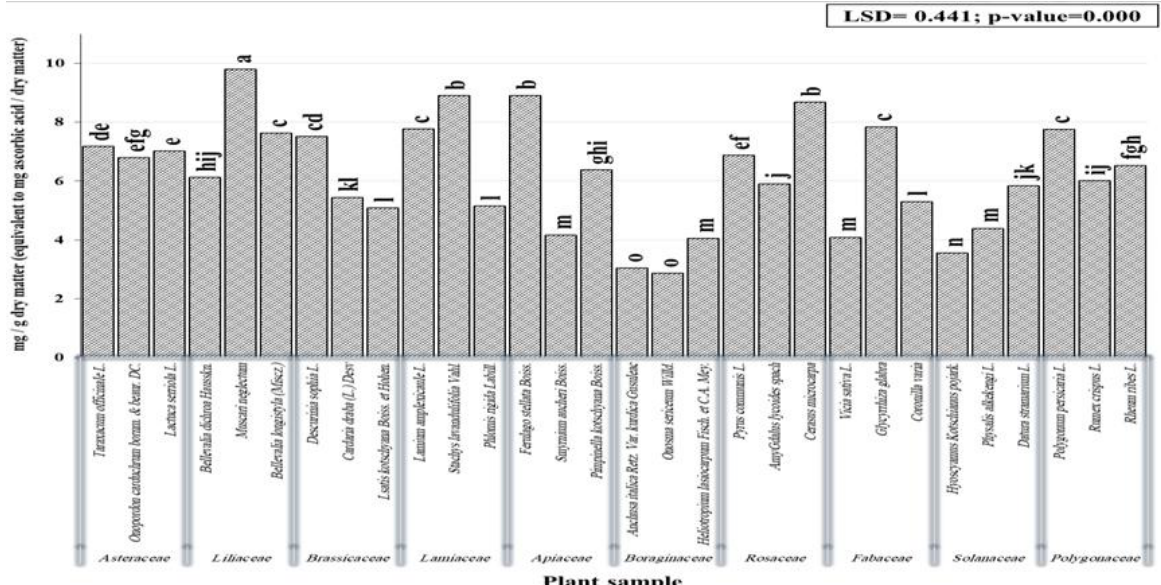
Fig. 6. Antioxidant capacity of studied plant species under the influence of plant family by TAC